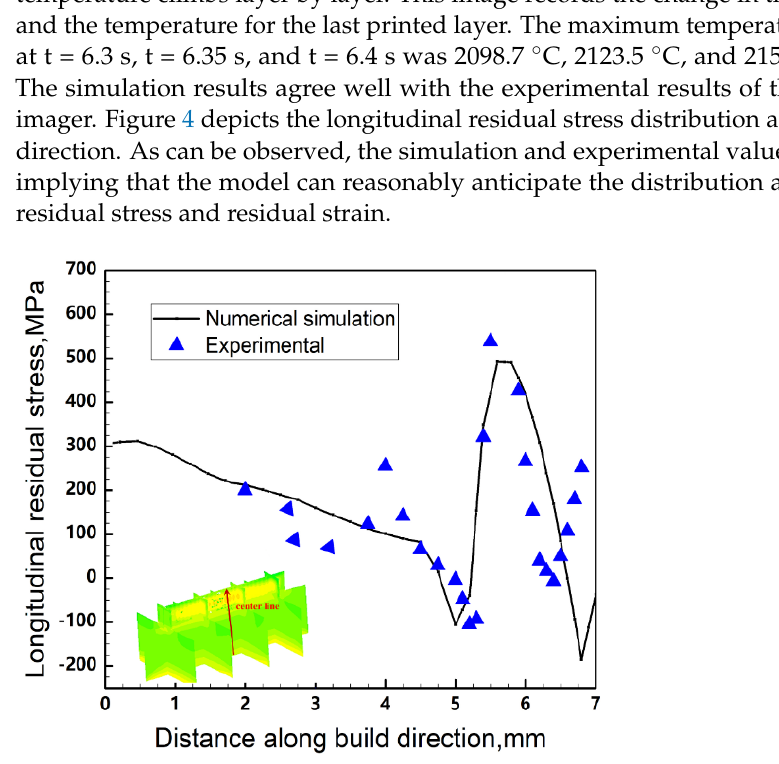
Figure 4. Comparison of experimental and simulated values of residual stress under a layer thickness of 200 μ m, a laser power of 400 W, and a scanning speed of 8 mm/s.